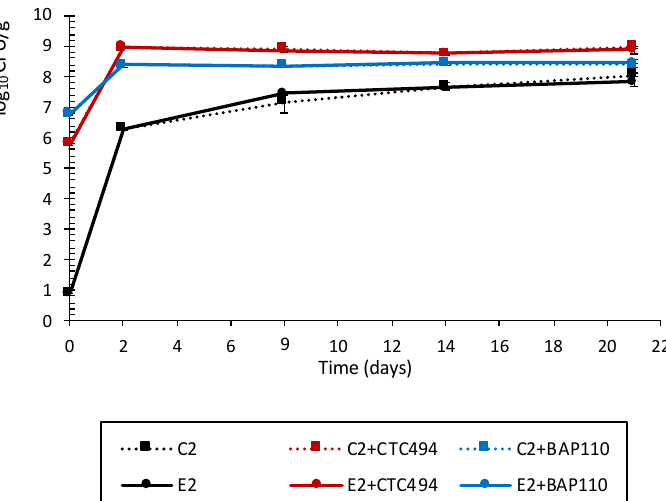
Figure 3. Growth of LAB in pork sausages spontaneously fermented with (E2) and without (C2) the addition of 0.3% LPE or fermented with the starter culture L. sakei CTC494 or L. sakei BAP110 and with (E2 + CTC494 or E2 + BAP110) or without (C2 + CTC494 or C2 + BAP110) the LPE.